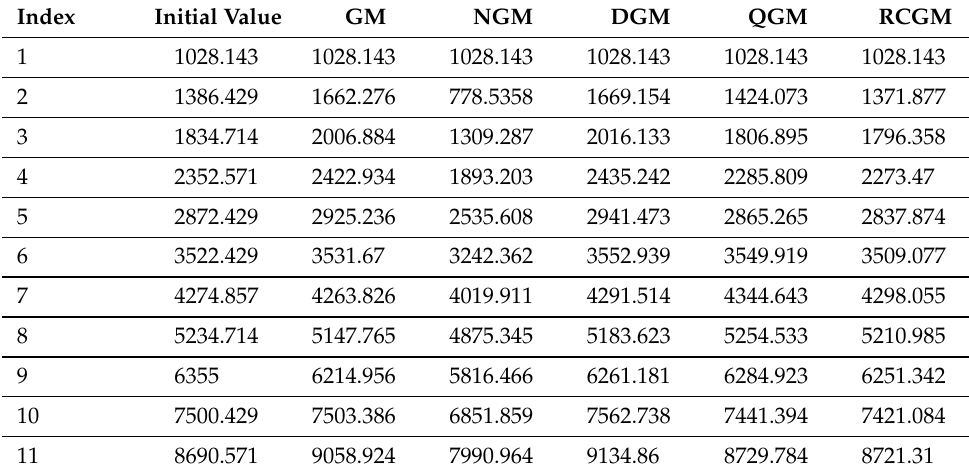
Table 3. Predicted values from Maharashtra data Model I.